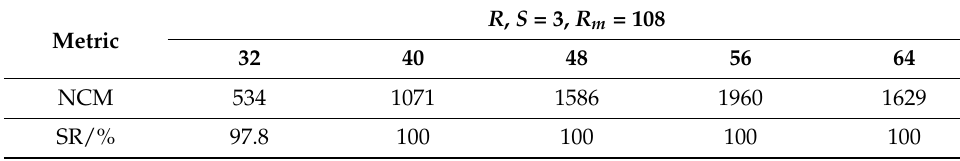
Table 3. The results of the parameter R .